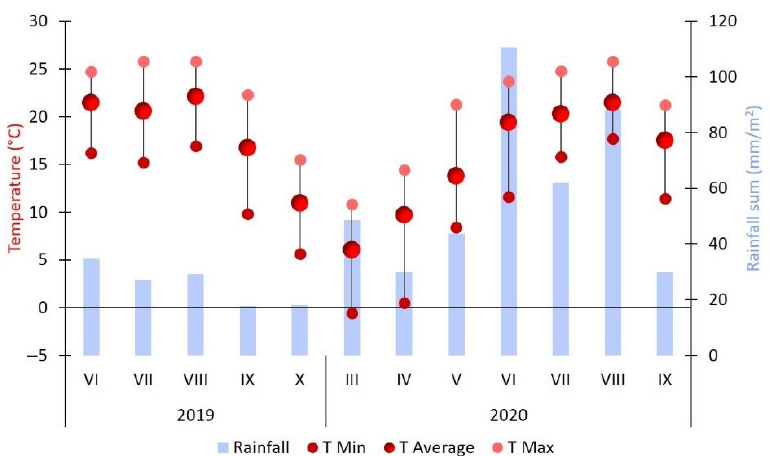
Figure 1. Weather conditions during the observation intervals in Cluj-Napoca, Romania; monthly mean temperature calculated based on daily average temperature; whiskers—minimum and maxi- mum average daily temperature registered (data according to UASVM Cluj weather station).